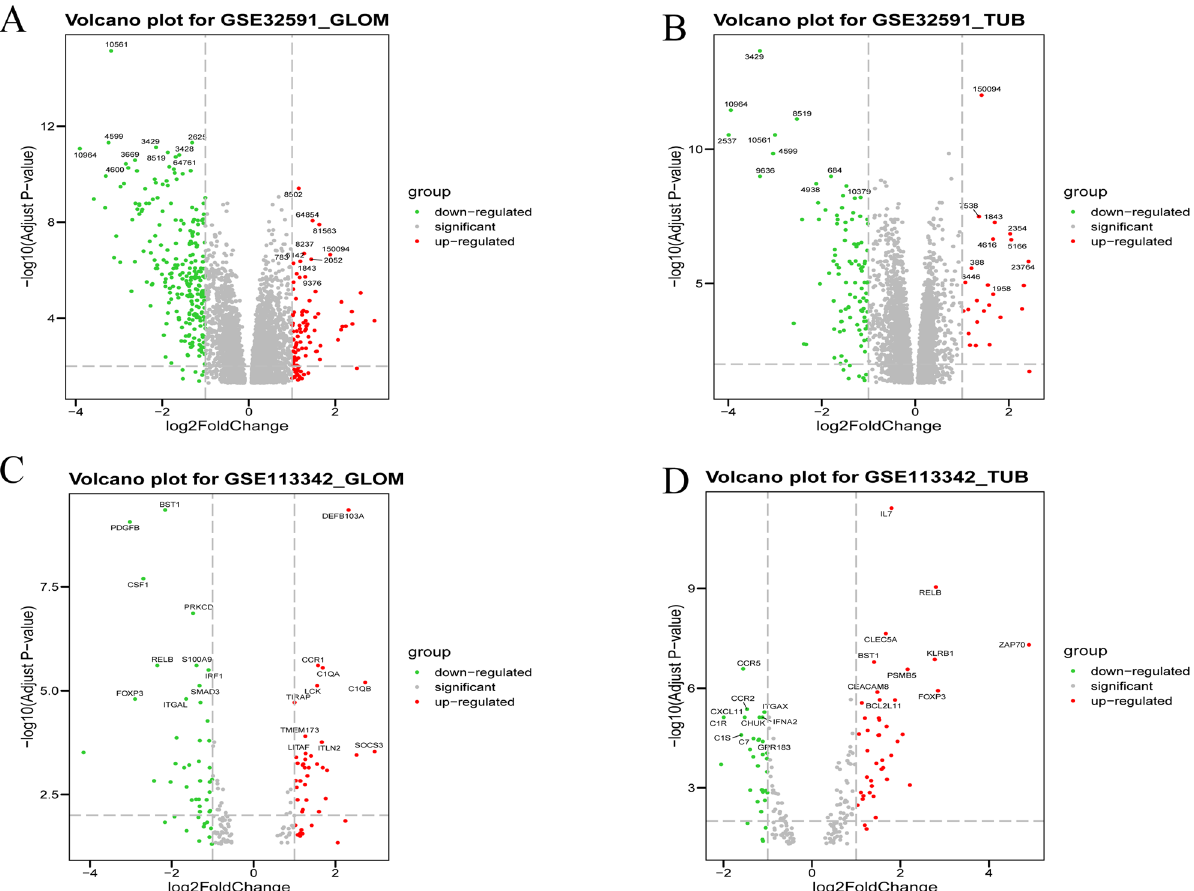
Figure 1. Volcano dots of differentially expressed genes (DEGs) from GSE32591 and GSE113342. Comparing with GSE113342, more DEGs were obtained from GSE32591. There were 4442 DEGs in GSE32591_GLOM group ( A ) and 5823 DEGs in GSE32591_TUB group ( B ), as well as 158 DEGs in GSE113342_GLOM ( C ) and 199 DEGs in GSE113342_TUB ( D